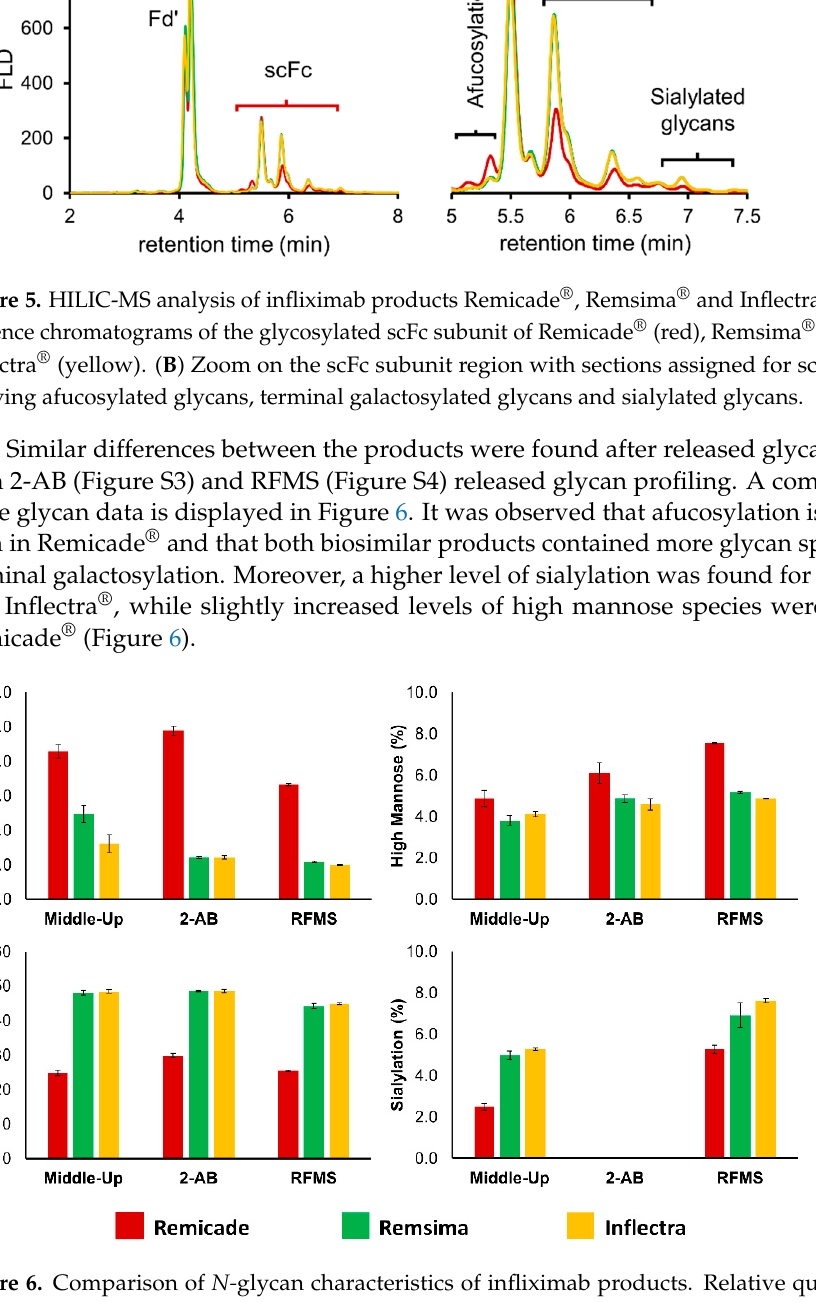
Figure 6. Comparison of N- glycan characteristics of infliximab products. Relative quantification performed with FLD for 2-AB and RFMS labeled N- glycans and MS detection for middle-up analysis of Remicade ® , Remsima ® and Inflectra ® . Afucosylation corresponds to the sum of the G0, G0-N, G1 afucosylated glycans. Sialylation corresponds to the sum of all sialylated glycans. Galactosylation corresponds to the sum of terminal galactosylated glycans. High mannose represents the M5 glycan species. Relative abundance levels provided in percentages with standard deviations ( n =